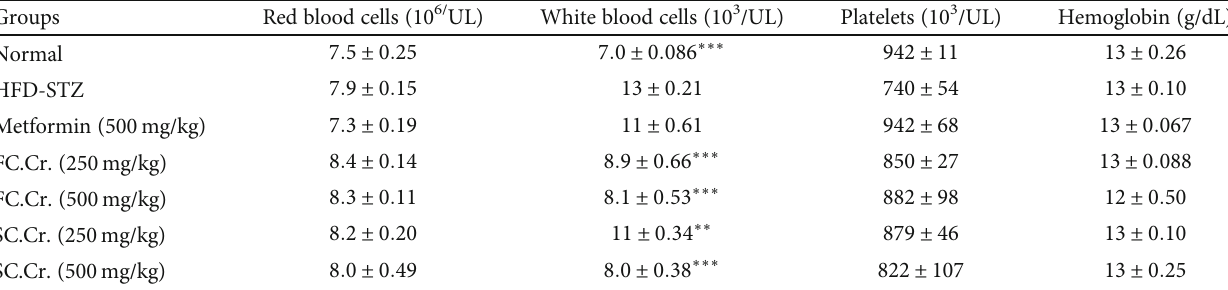
Table 1: Complete blood count (CBC) of the experimental animals.